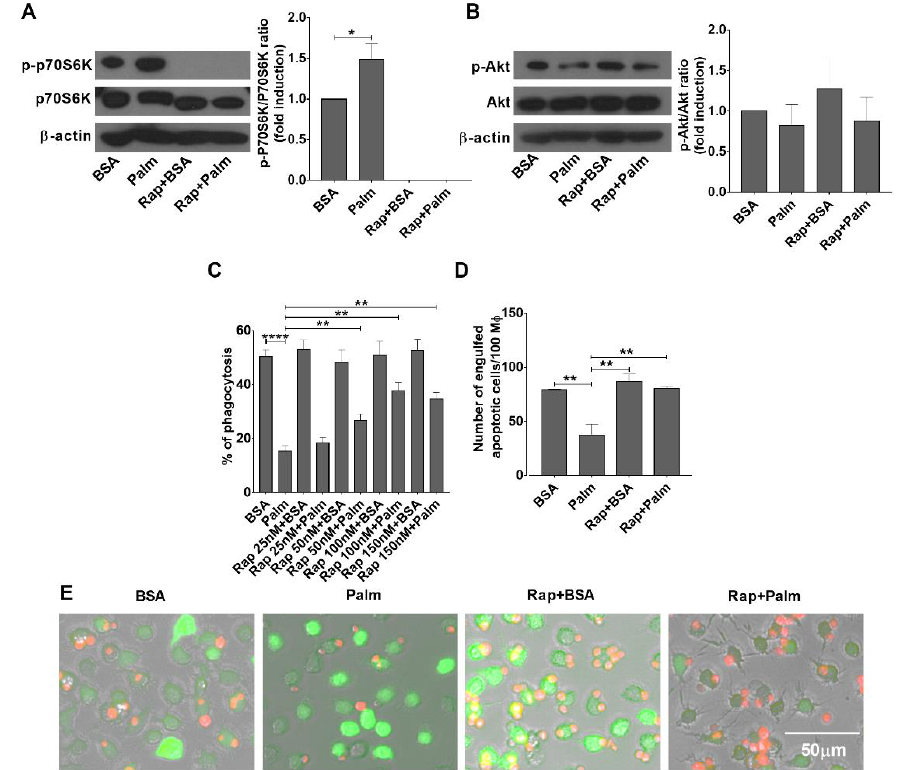
Figure 3. Exposure of BMDMs to palmitate results in mTORC1 activation leading to inhibition of efferocytosis. ( A ) Exposure of BMDMs to 0.4 mM palmitate for 24 h leads to an increased Thr 389 phosphorylation of p70S6K1, a downstream substrate of mTORC1, while it decreases following exposure to rapamycin (100 nM), detected by Western blot analysis. β -actin was used as a loading control. One representative gel of three is shown. ( B ) Exposure of BMDMs to 0.4 mM palmitate or to rapamycin (100 nM) for 24 h does not affect the Ser 473 phosphorylation of Akt, a substrate of mTORC2 in BMDMs, detected by Western blot analysis. β -actin was used as a loading control. One representative gel of three is shown. Rapamycin (100 nM), an mTORC1 inhibitor, attenuates the efferocytosis inhibition of BMDMs induced by palmitate exposure for 24 h detected by ( C ) determining the percentage of engulfing macrophages by FACS analysis or by ( D ) counting the number of engulfed cells. All data are expressed as mean ± SD ( n = 4). Asterisks indicate statistically significant difference (* p < 0.05, ** p < 0.01, and **** p < 0.001). ( E ) Representative fluorescent microscopic images of macrophages (green) engulfing apoptotic thymocytes (red) following 40 min of efferocytosis in the presence or absence of 0.4 mM palmitate with or without 100 nM